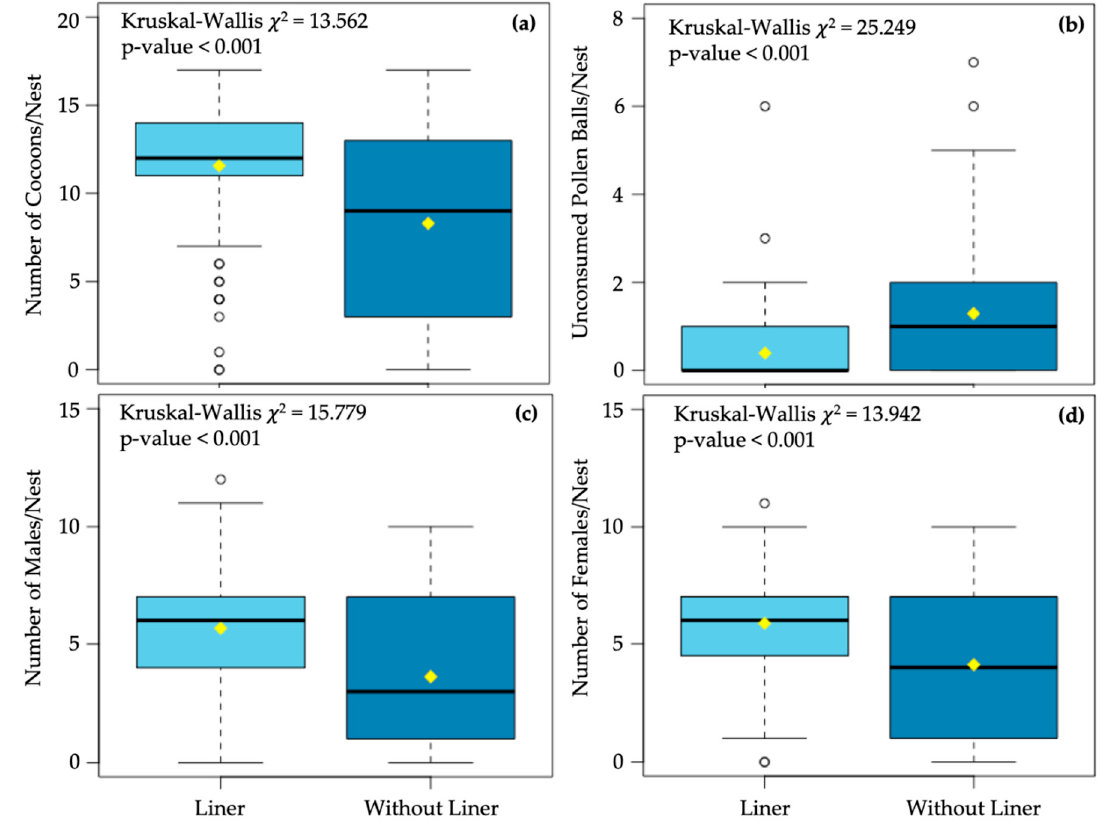
Figure 2. Impact of deploying Osmia cornifrons nests with and without paper liners on the mean number of cocoons ( a ), unconsumed pollen balls ( b ), male ( c ), and female ( d ). In each plot, the thick horizontal line represents median, the yellow diamond indicates sample mean, and the box indicates the 25th–75th percentile range. The total range of the data in each plot is shown with whiskers, and open circles represent outliers. The Kruskal–Wallis rank sum test was performed for significance test ( p -value < 0.05).